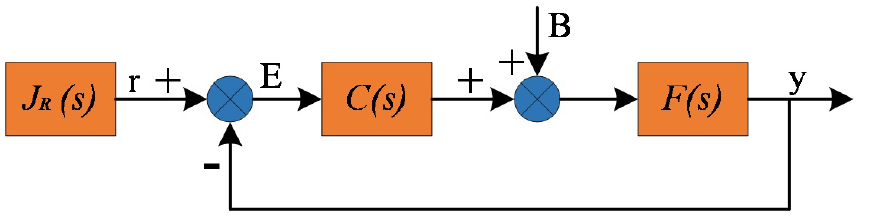
Figure 5. Internal model theory based